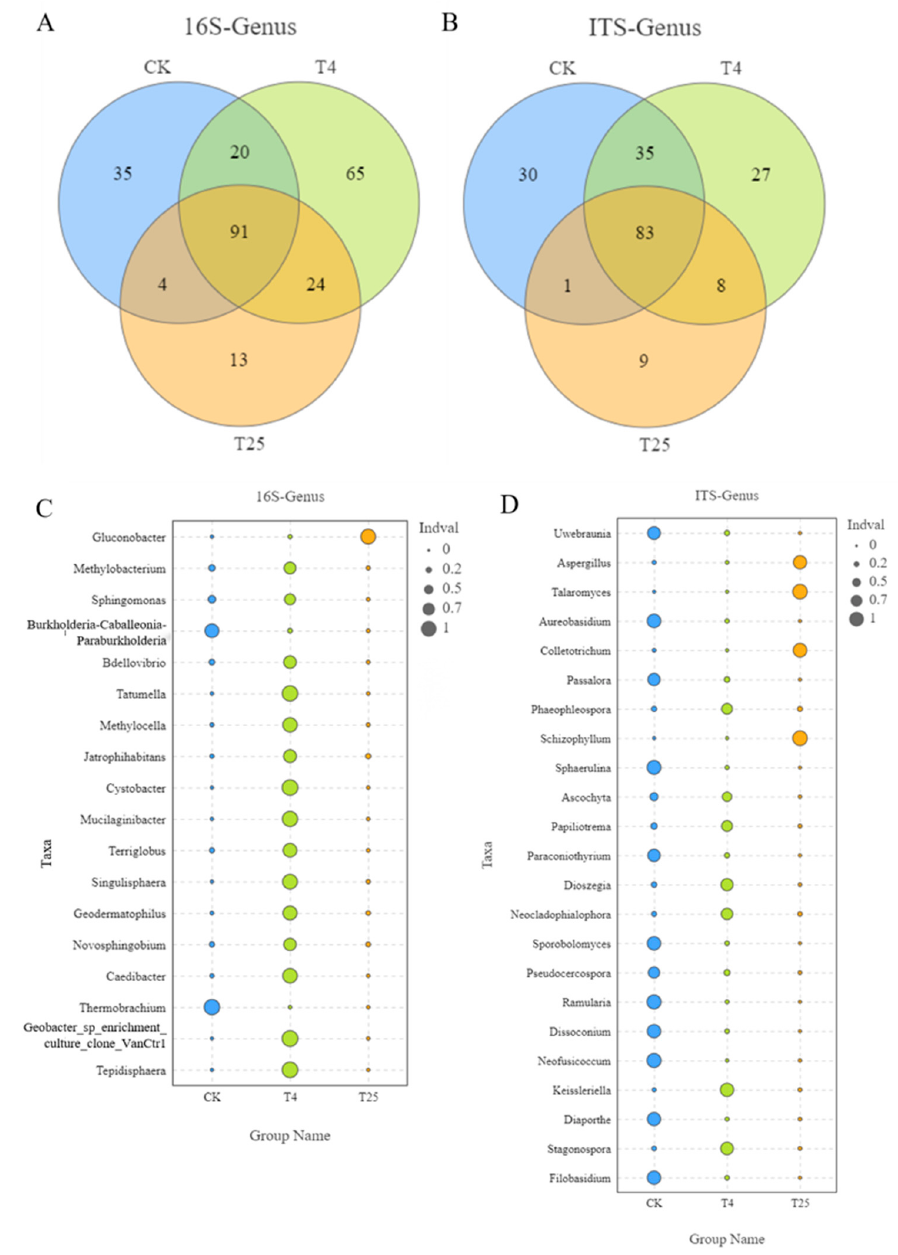
Figure 4. Venn plot of bacterial ( A ) and fungal ( B ) operational taxonomic units (OTUs) in all samples. Indicator diagram of bacterial ( C ) and fungal ( D ) genus level